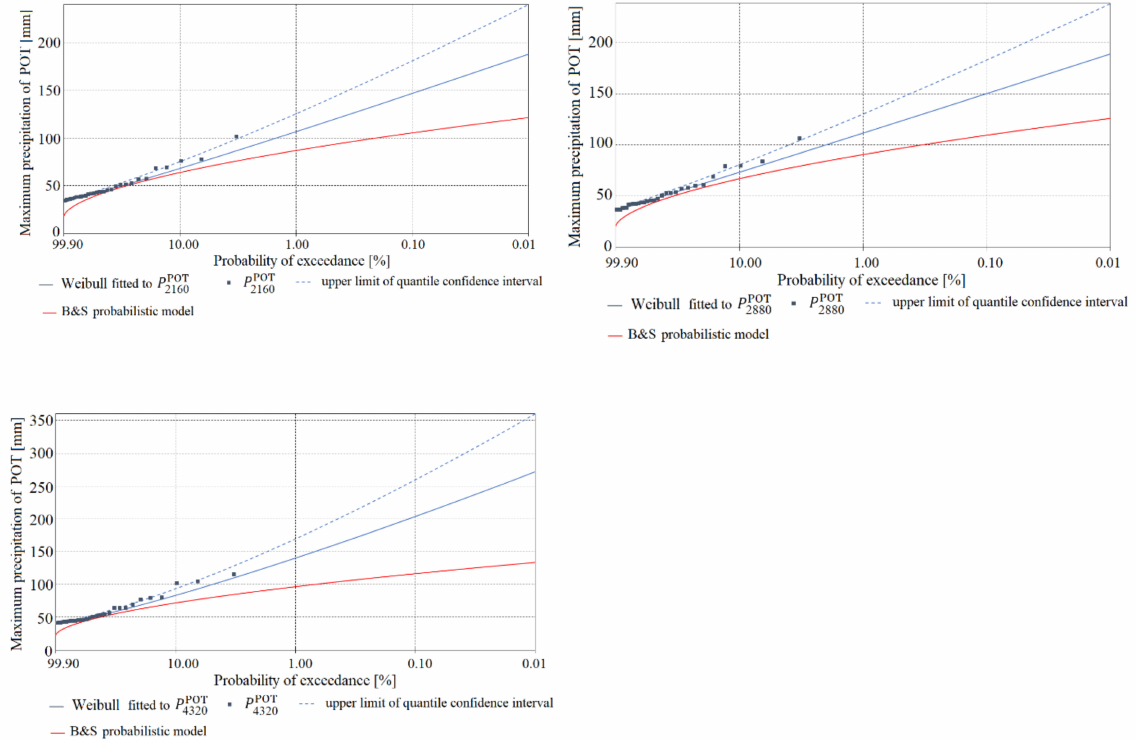
Figure 10. Plots of functions of probability of exceedance for the random variables P POT τ where τ = {2160, 2880, 4320} min, for the most credible probability distributions, with indication of upper limits of quantile confidence intervals according to the PMAXTP method, compared with the model of Bogdanowicz and Stach ý , for the Bialystok meteorological